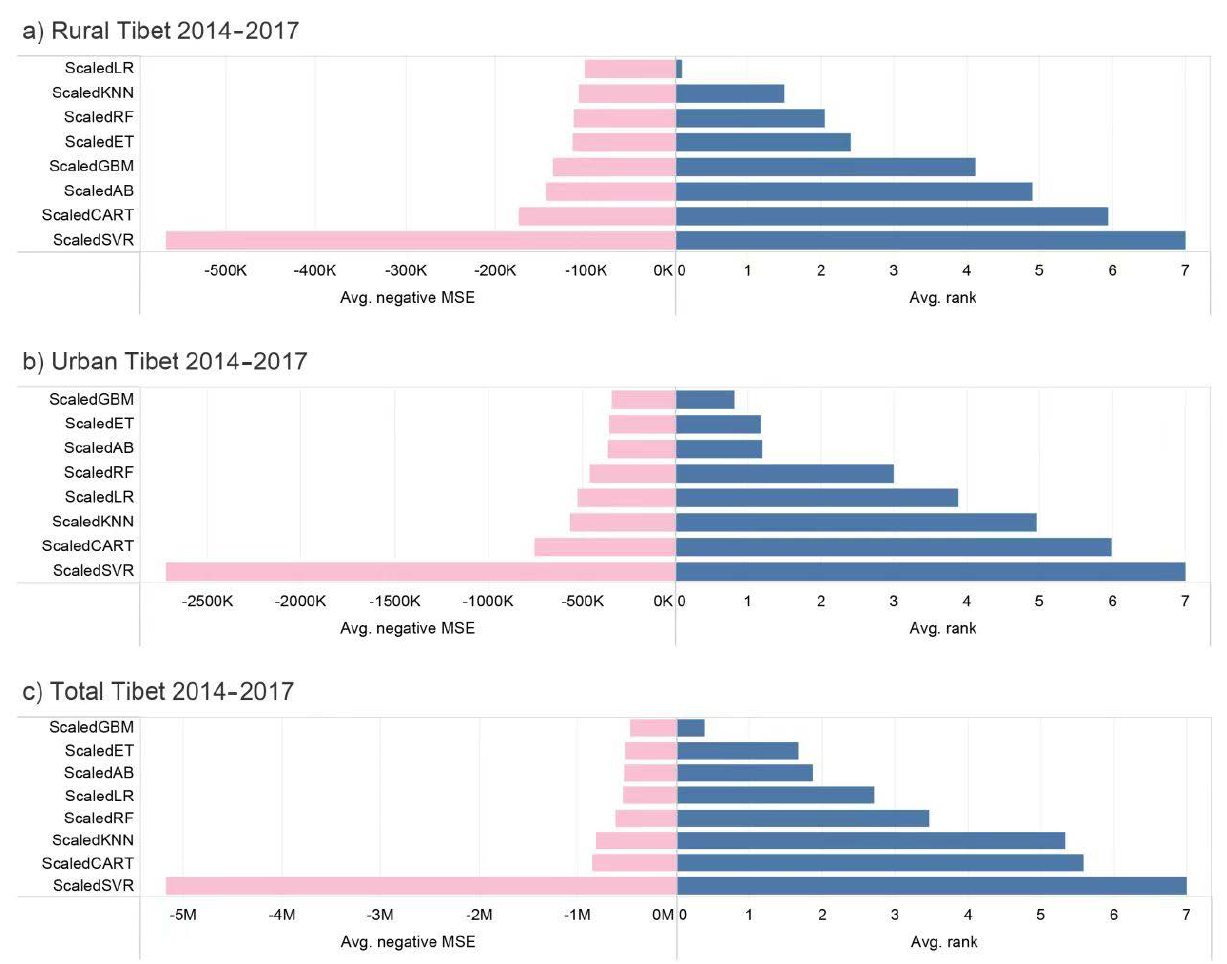
Figure 2. Algorithm baseline performance using the rural ( a ), urban ( b ), and total ( c ) Tibet datasets. Negative MSEs of different algorithms for different data are shown in pink and their average ranking for the 100 runs is shown in blue. The shorter the combination of the two bars, the better the performance of a given algorithm. GBM, gradient boosting machine; ET, extra trees; KNN, k-nearest neighbors; AB, adaptive boosting; RF, random forest; CART, classification and regression tree; SVR, support vector regression; LR-simple linear regression model, i.e., ordinary least squares (OLS) model.